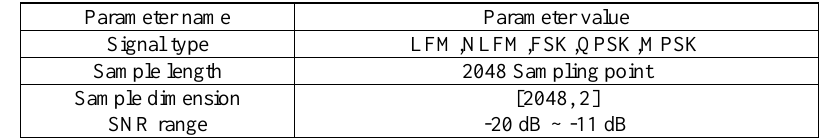
Table 1. Structure of the